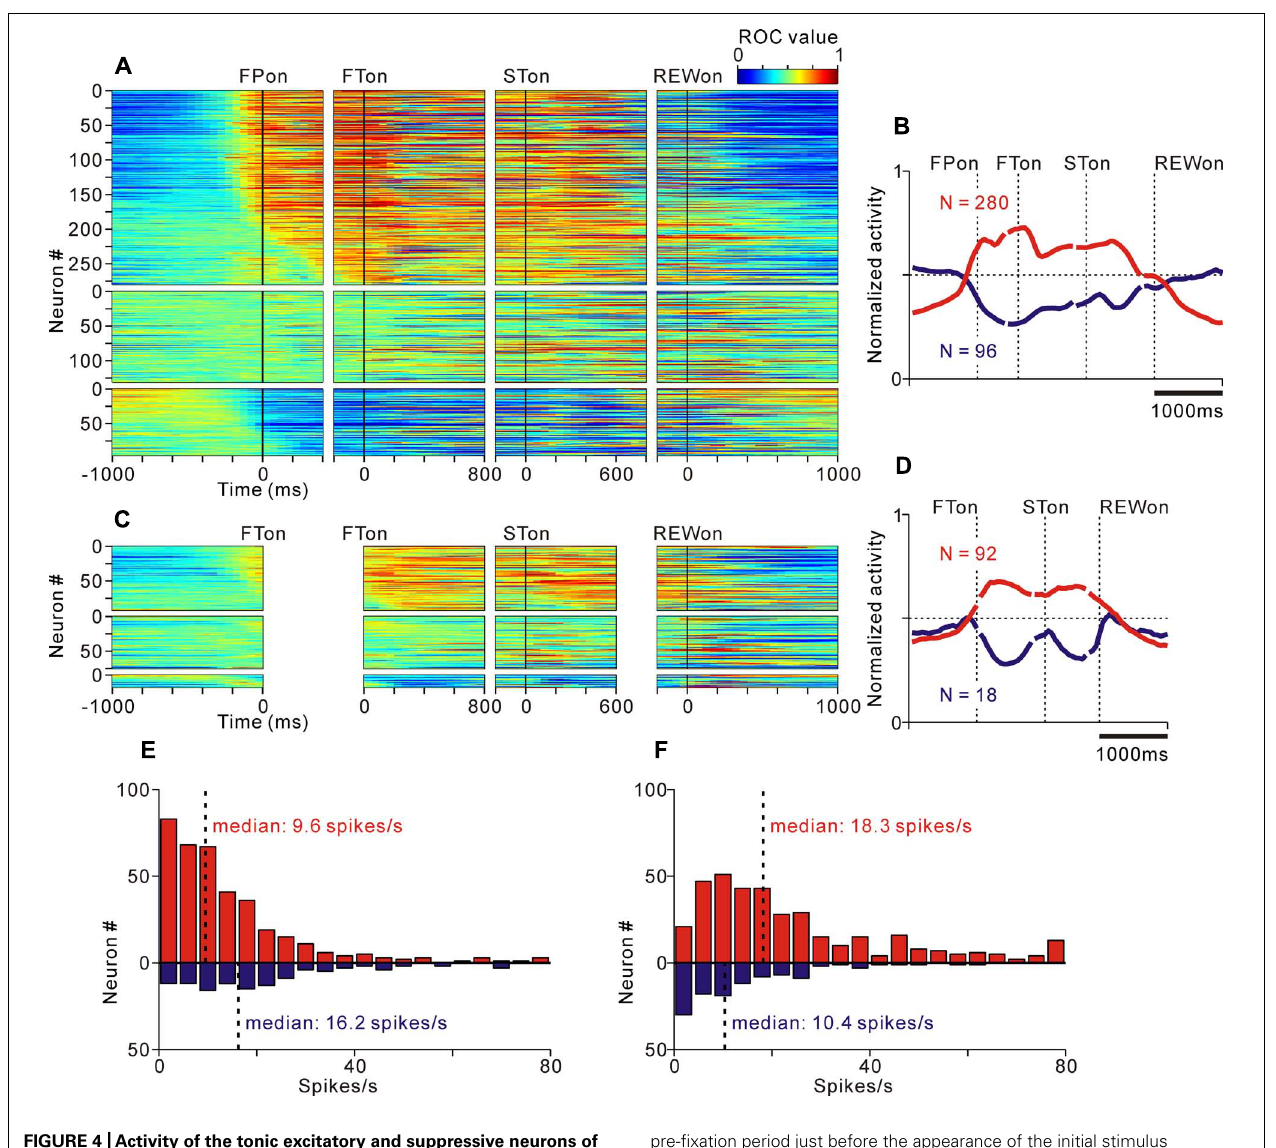
pre-fixation period just before the appearance of the initial stimulus (600 ms duration) and a test window centered on the pixel (200 ms duration).The warm colors (ROC value > 0.5) indicate increases in the firing rate relative to the pre-fixation period, whereas the cool colors (ROC value < 0.5) indicate decreases in the firing rate. (B–D) Population average activity is shown for the task with (B) and without (D) FP presentation, separately for tonic excitatory neurons (red) and tonic suppressive neurons (blue). (E,F) Histograms for the firing rate during the pre- (E) and post-fixation (F) periods for the tonic excitatory (red) and suppressive (blue)